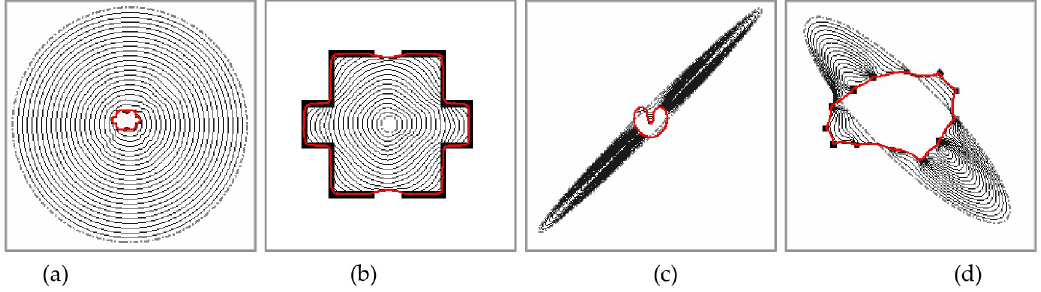
Fig 2. Some common properties of the MCONVEF Snakes: Large capture range, initialization insensitivity, and subject contour